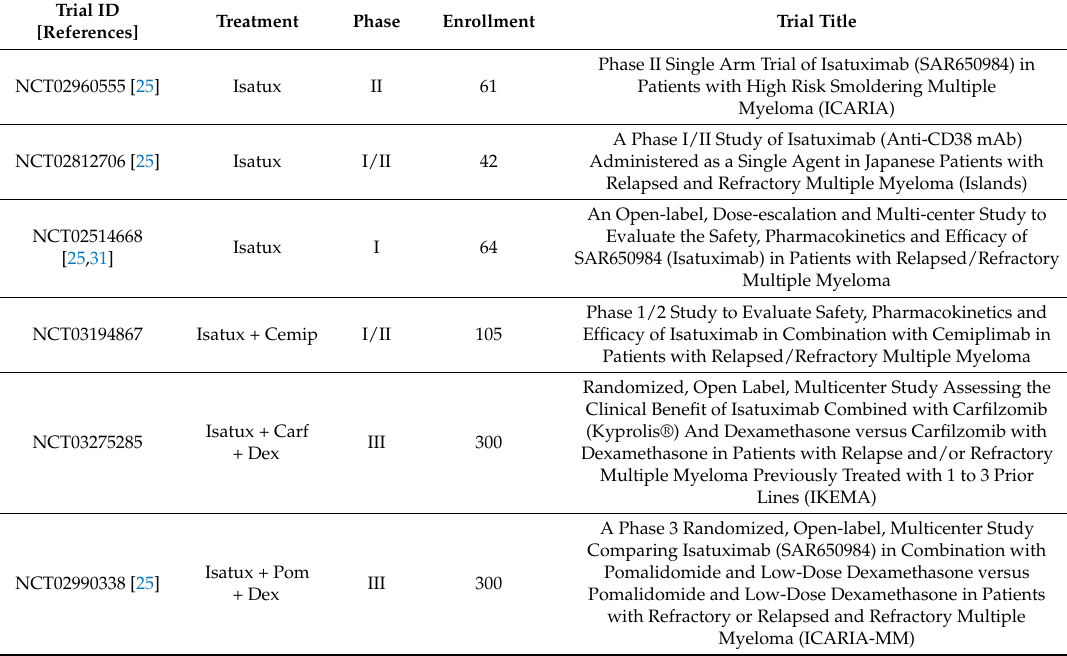
Table 2. Active Trials of Isatuximab in